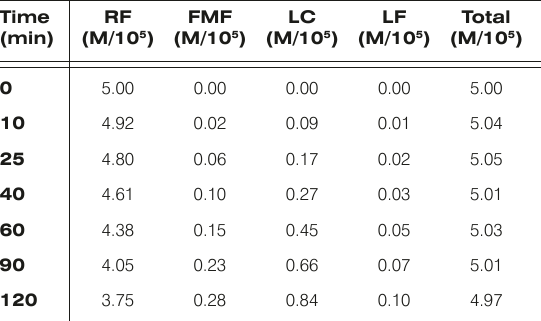
Table 2. Photolysis of 5×10 –5 M RF solution in the presence of 2.5×10 4 M caffeine solution at pH 7.0 [57].